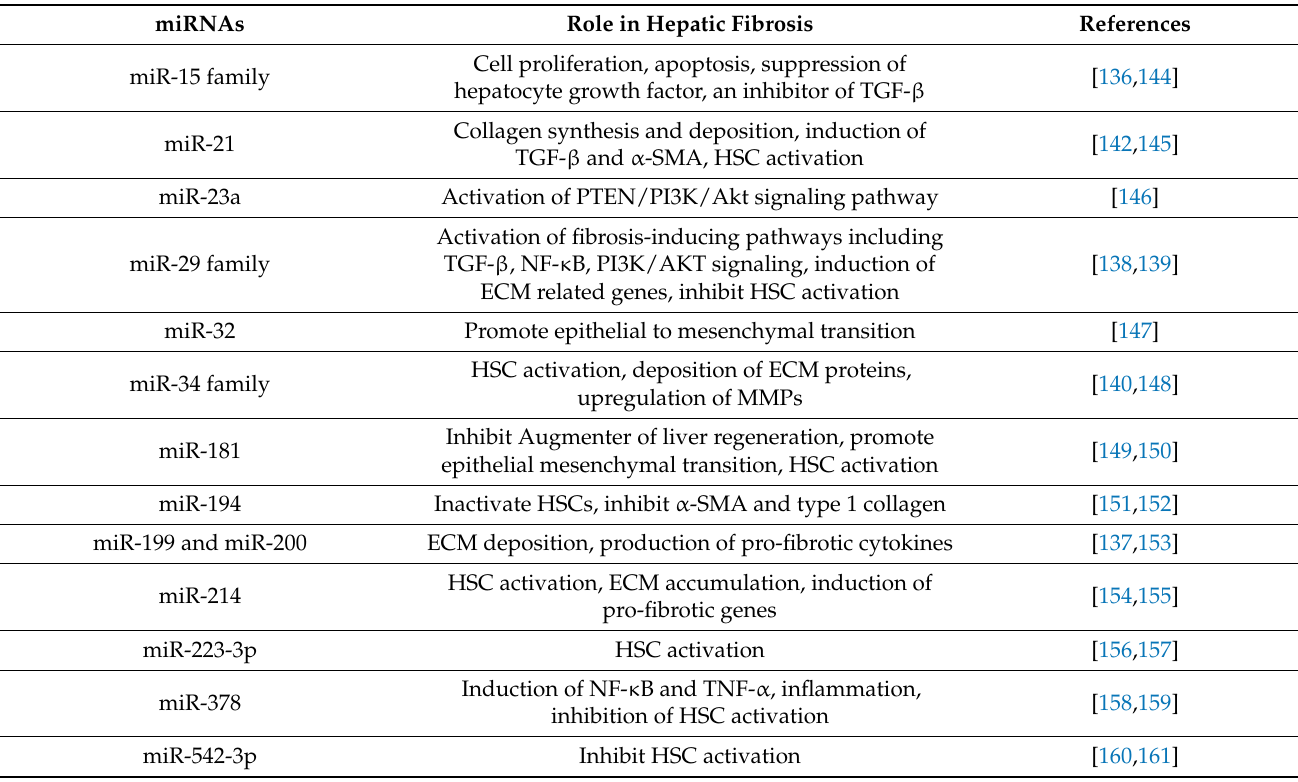
Table 1. Role of miRNAs in hepatic